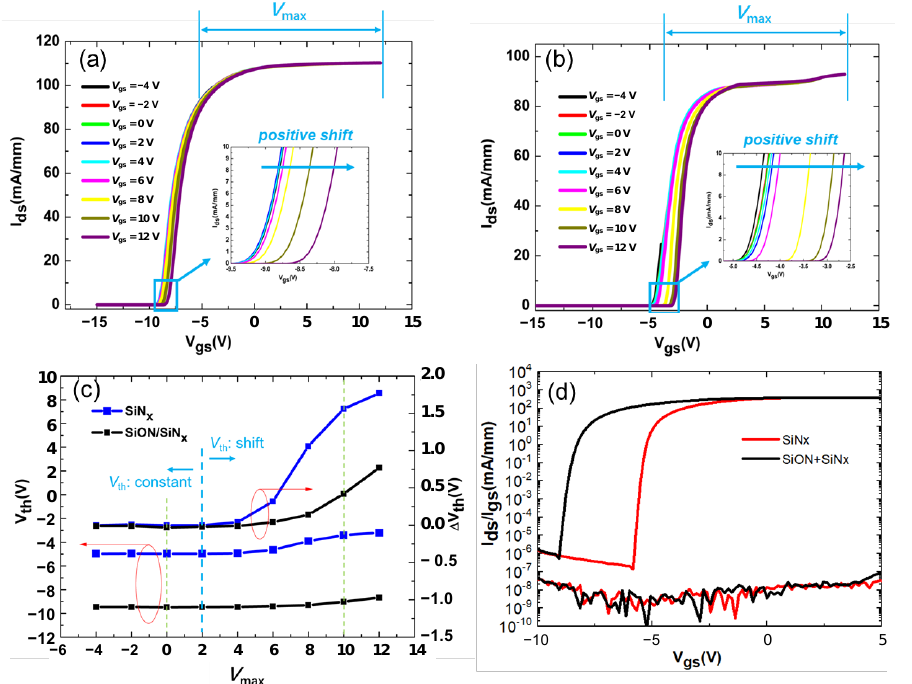
Figure 2. Transfer characteristics of AlGaN/GaN MIS-HEMTs with ( a ) SiN x /SiON dual layers and ( b ) SiN x layer under various gate-source voltage sweeps. ( c ) The threshold voltage (V th ) and the Vth hysteresis (∆V th ) as a function of gate voltage stress (V max ). ( d ) Gate leakage comparison.